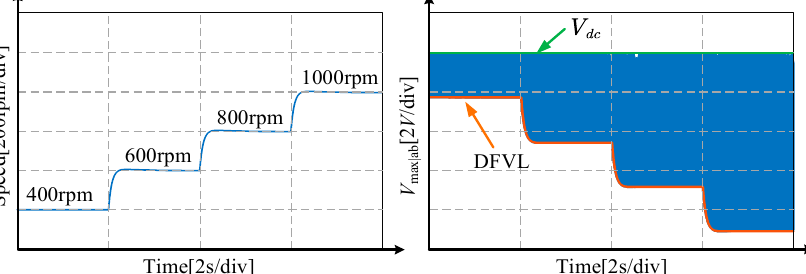
Figure 7. Experimental results of DFVL from 400 rpm to 1600 rpm.